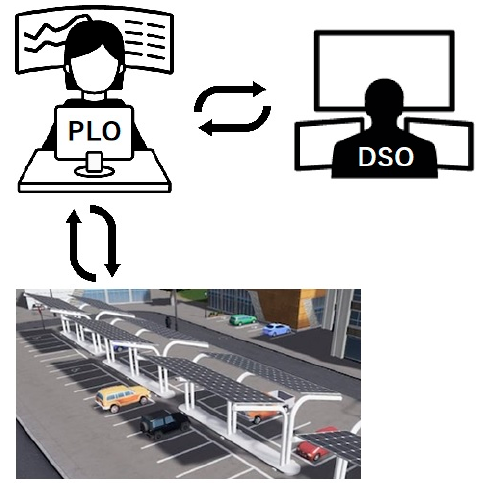
Figure 1. Interaction between PLO, DSO and PEV.